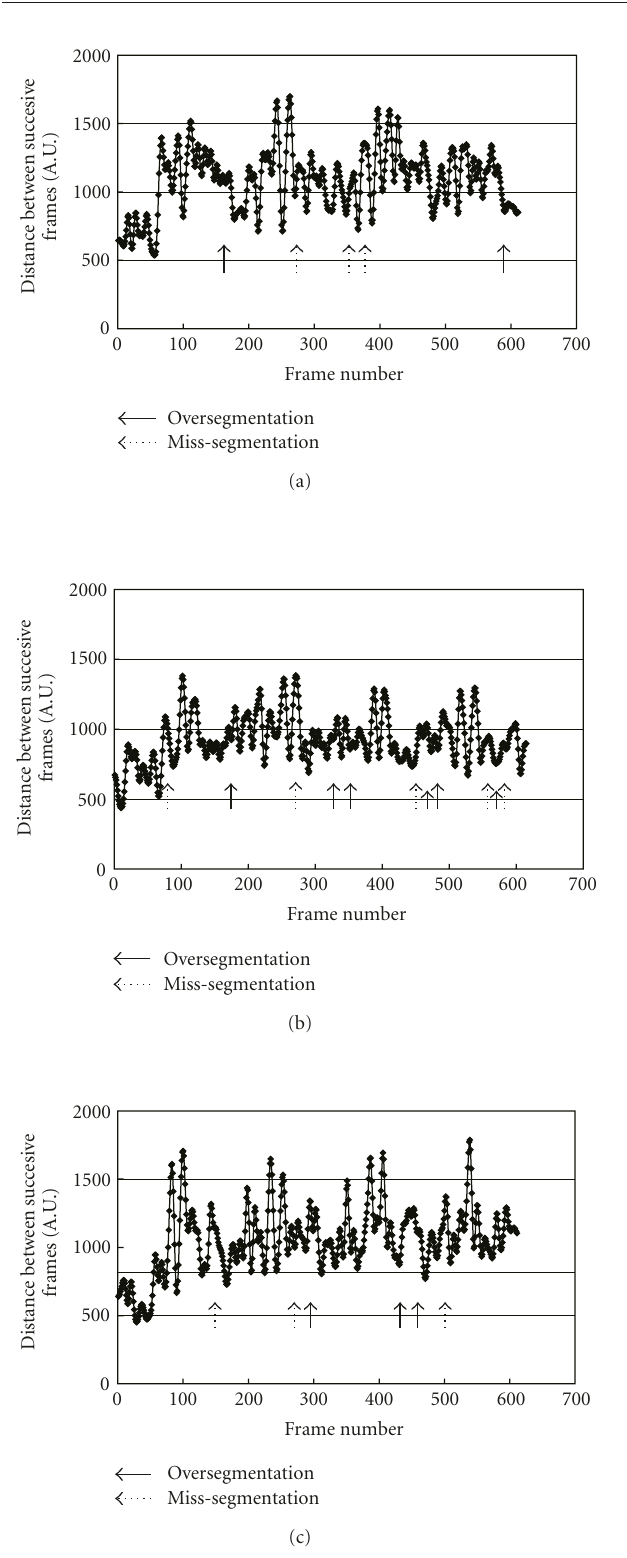
Figure 6: Segmentation results for sequences #2-1 (b) #2-2, (c) #2-3. The meanings of arrows are di ff erent from Figure 5. Solid arrows represent oversegmented points, and dotted arrows are miss-segmented points. The other local minima points coincided with authors’ definition of segmentation boundaries.